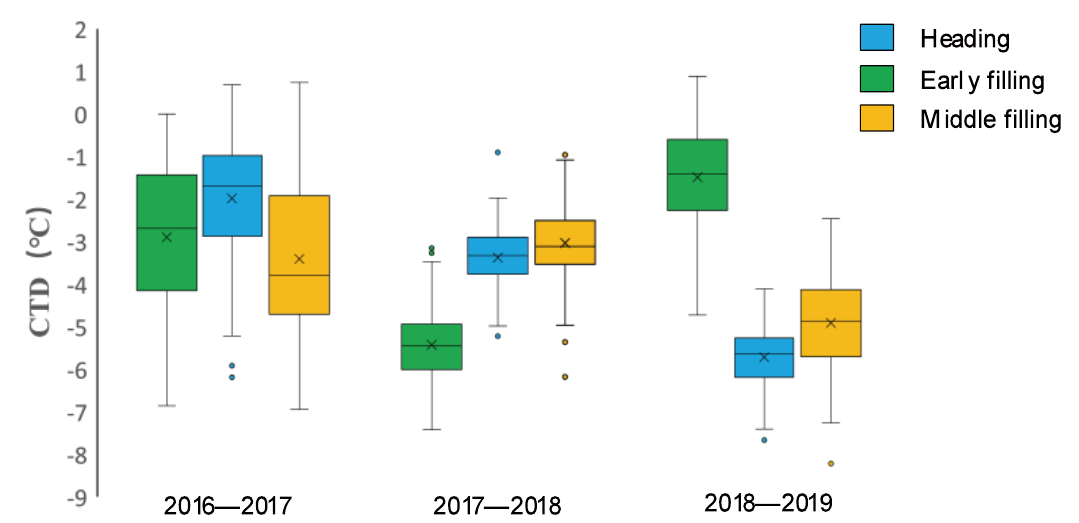
Figure 2. The variations in the CTD value of wheat varieties at the three growth stages of the three wheat growth seasons are shown in boxplot diagrams. CTD variations were more obvious among wheat varieties, with similar trends observed among wheat varieties at the three key growth stages in the 2016–2017 (normal) growing season, while the overall variations in CTD in the heading and early filling stages were smaller in the 2017–2018 (spring freezing) growing season. The greatest number of variations in CTD were at the heading stage, and the smallest were at the early filling stage in the 2018–2019 (early drought) growing season.